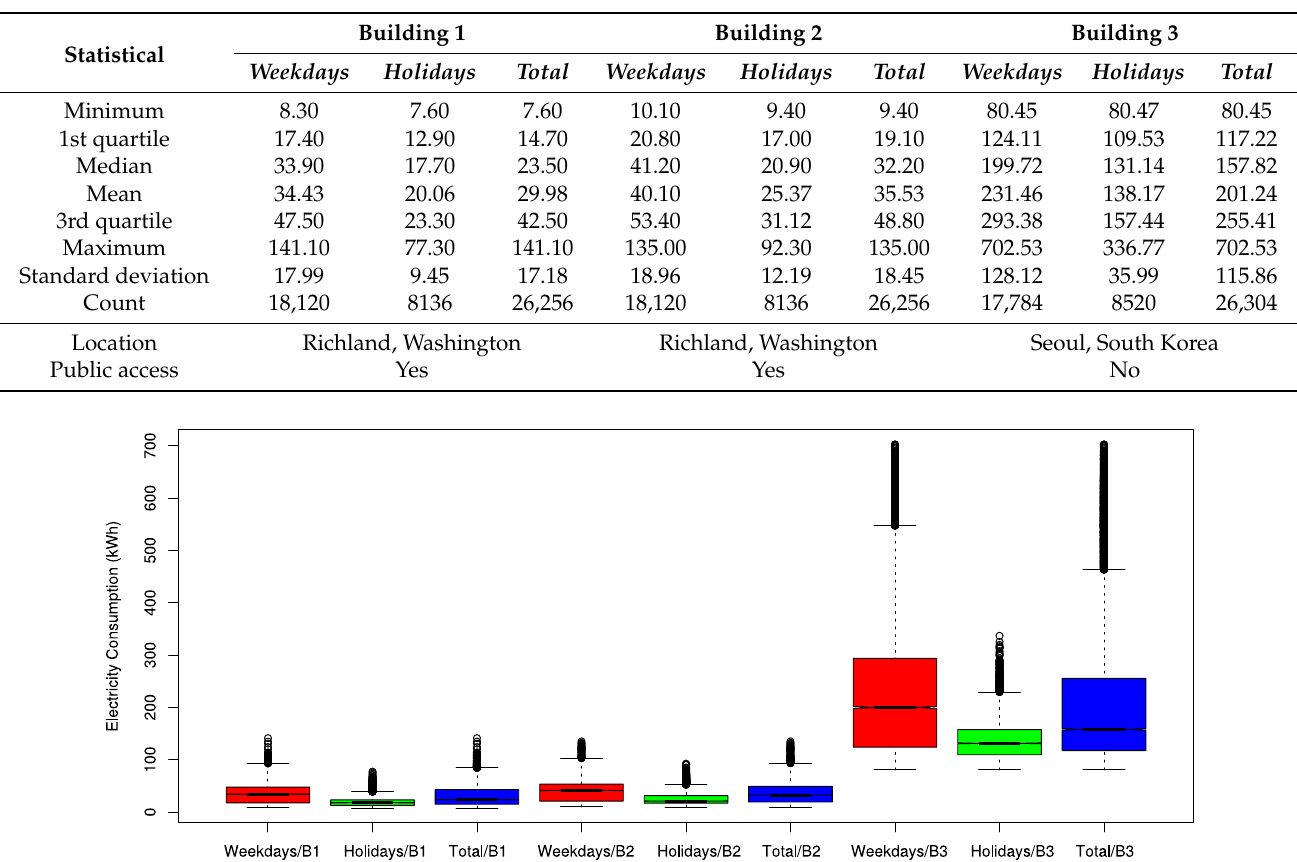
Figure 1. Box plots for the electricity consumptions of three buildings (B1, B2, and B3 represent Building 1, Building 2, and Building 3, respectively).